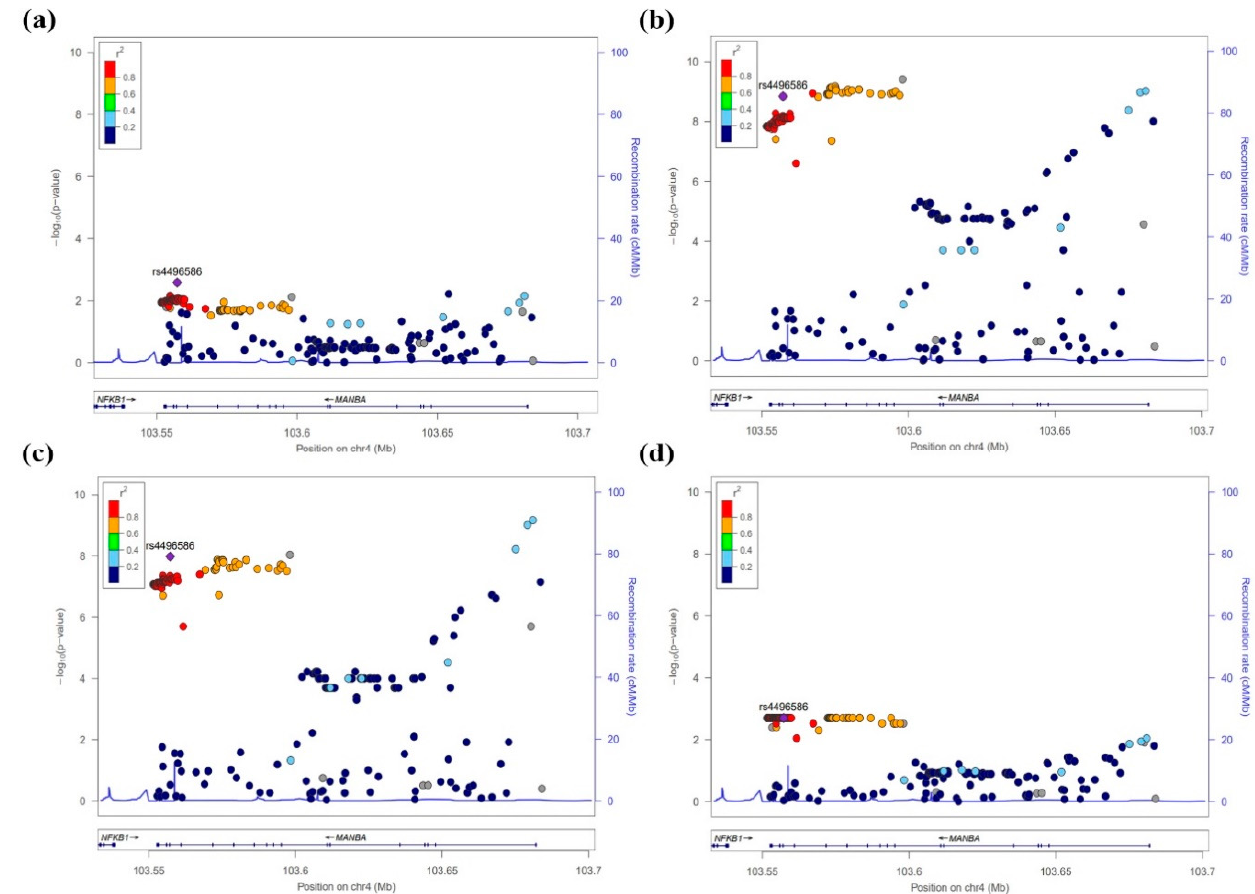
Figure 2. Regional plots of the association results of MANBA SNPs with CKD ( a ) and kidney function-related traits such as eGFR ( b ), creatinine ( c ), and uric acid levels ( d ) in the HEXA cohort. The statistical significance ( − log 10 p -value) of the analyzed SNPs is plotted. The colors indicate the linkage disequilibrium ( r 2 ) between rs4496586 and the remaining SNPs. The genetic recombination rates are shown on the right y -axis. The plots were generated by the LocusZoom program (http://csg.sph.umich.edu/locuszoom (accessed on 13 April 2021)).